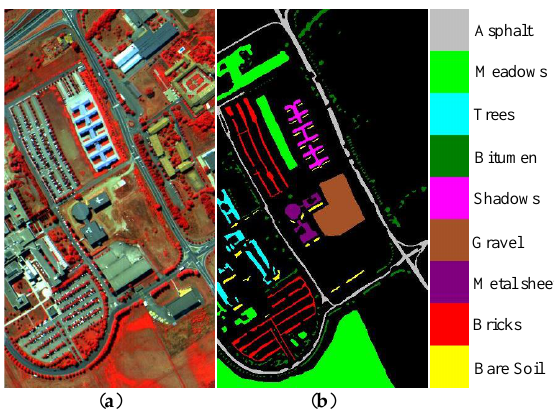
Figure 7. University of Pavia dataset. ( a ) Three-band false-color image. ( b ) Ground truth-map reference. The Salinas dataset was acquired by the AVIRIS sensor over Salinas Valley, California. This image has 512 × 217 pixels with a spatial resolution of 3.7 m and 204 spectral bands after removing 20 water absorption bands. This image contains sixteen classes of interest. Figure 8 shows the false-color composite of the Salinas image and the corresponding ground reference map.